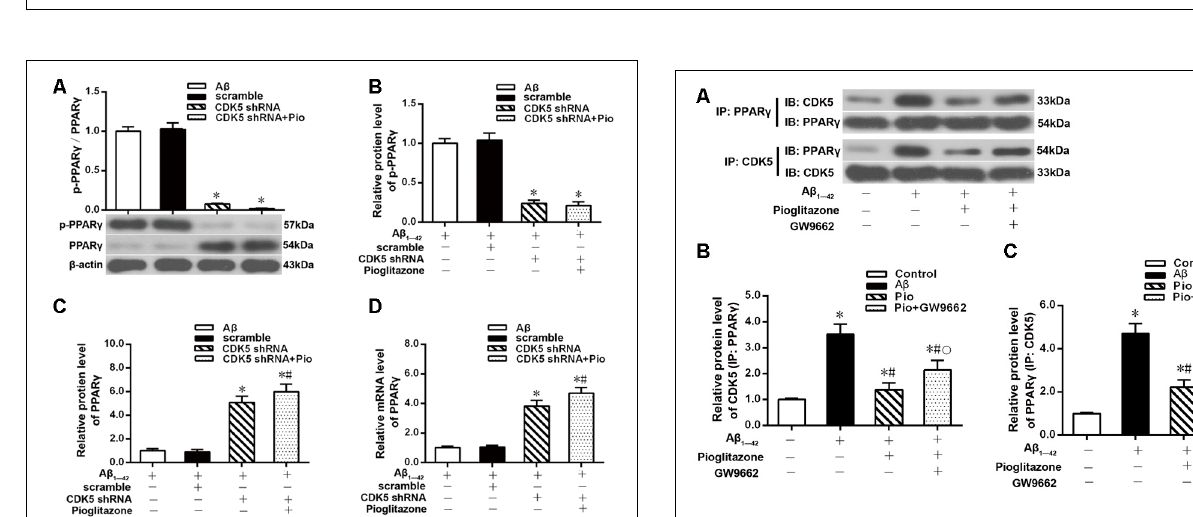
FIGURE 7 | Effects of pioglitazone and A β 1–42 on PPAR γ phosphorylation in AD model neurons. (A) Intergroup comparisons of p-PPAR γ /PPAR γ ratios. (B) Intergroup comparisons of the p-PPAR γ protein levels. (C) Intergroup comparisons of PPAR γ protein levels. (D) Intergroup comparisons of PPAR γ mRNA levels. (E) Intergroup comparisons of CDK5 protein levels. (F) Intergroup comparisons of CDK5 mRNA levels. n = 6 wells per group. ∗ P < 0.05 compared to the control group, # P < 0.05 compared to the A β group, ◦ P < 0.05 compared to the Pio group.